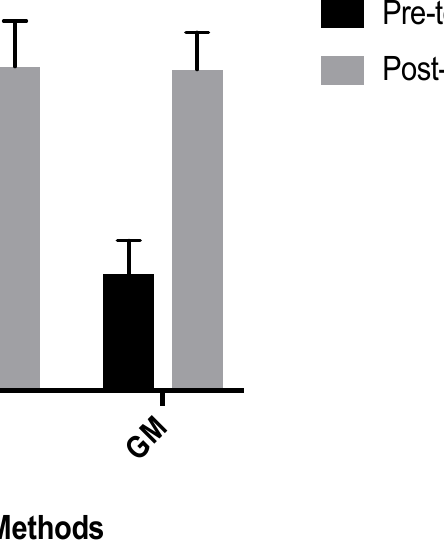
Figure 5. Mean (SD) test scores for the three teaching groups. Notes: The mean difference indicates significance at the p < 0.05 level (TT: Traditional Teaching method; GBL: Game-Based Learning; and GM: Gamification) .